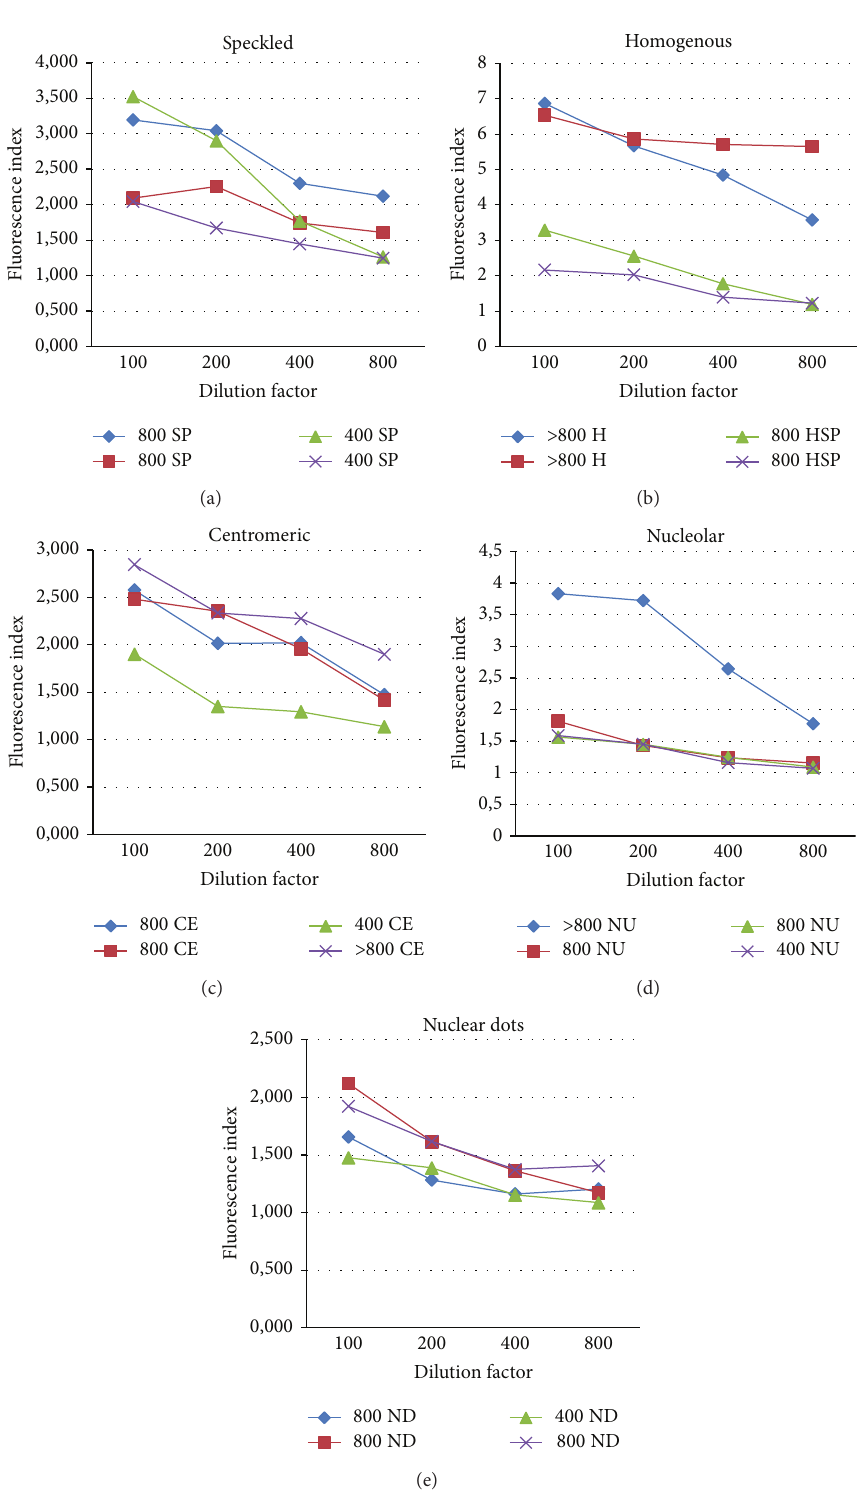
Figure 4: Study of fluorescence index as a function of dilution. Twenty ANA positive samples with different fluorescence patterns were dilutedfrom1:100to1: 800.Foreachfluorescencepattern,fourrepresentativesampleswerediluted.Foreachsample,onecurverepresentsthe fluorescence index plotted as a function of dilution factor. SP: speckled, NU: nucleolar, H: homogenous, ND: nuclear dots, HSP: homogenous- speckled, and CE: